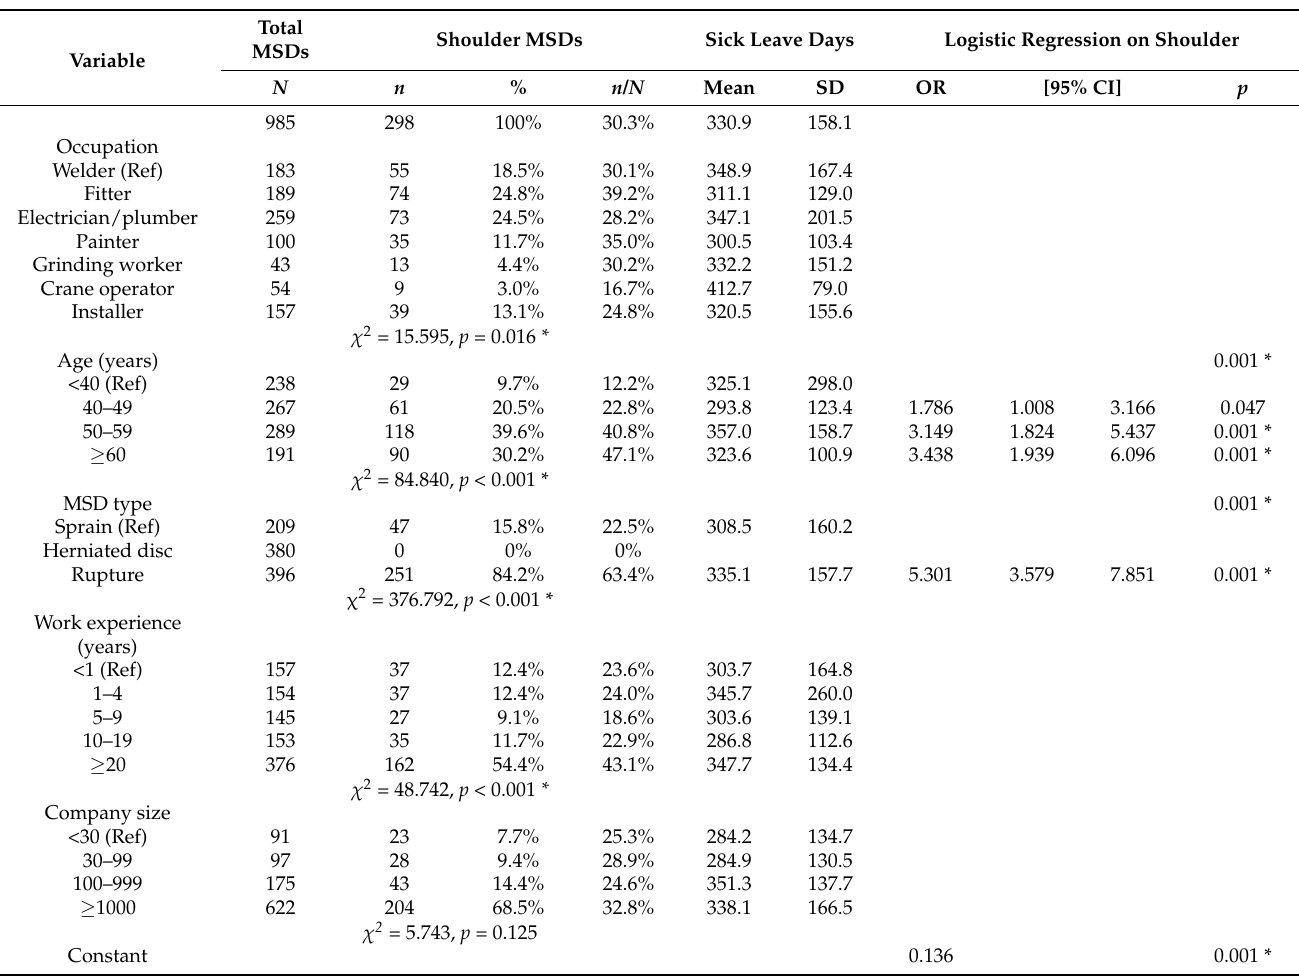
Table 4. Distribution and sick leave days of shoulder MSDs and factors associated with shoul- der